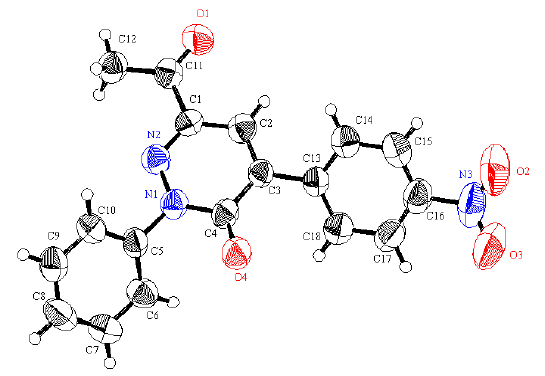
Figure 3. ORTEP plot of the X-ray crystallographic data determined for 3l